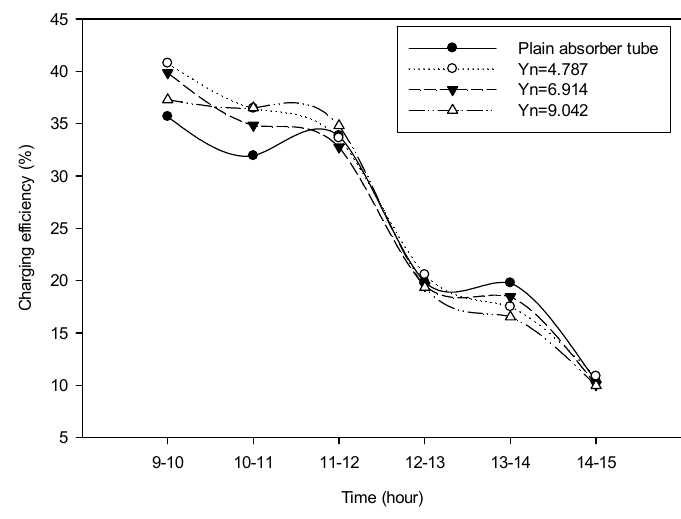
Figure 13. Variation in charging efficiency with time and nail twist pitch ratio.